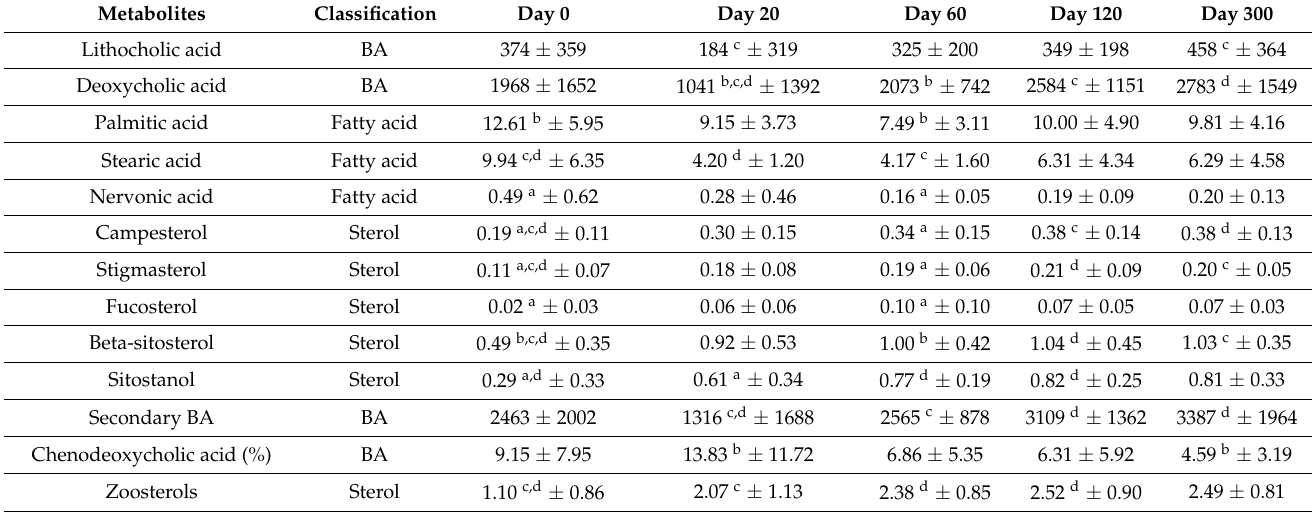
Table 6. Concentrations of fecal metabolites that significantly differed over time within AMC cats.